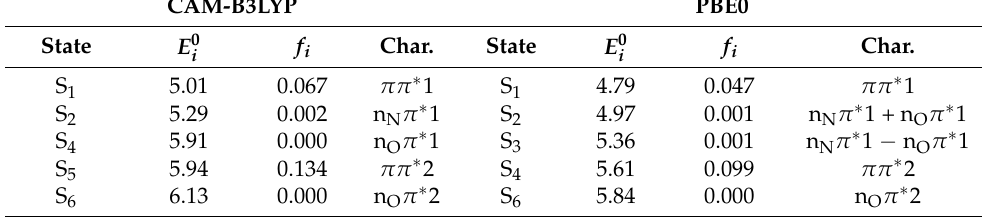
Table 1. Energies ( E 0 ), oscillator strengths f i , and electronic characters for the predominant excited i states of the pyrimidine bases involved in the dynamics, calculated at the ground-state minimum (FC point, C s symmetry). CAM-B3LYP and PBE0 calculations with 6-311+G(d,p) basis set in gas phase. Energies in eV. Uracil CAM-B3LYP PBE0 f i Char. State Char. State E 0 i